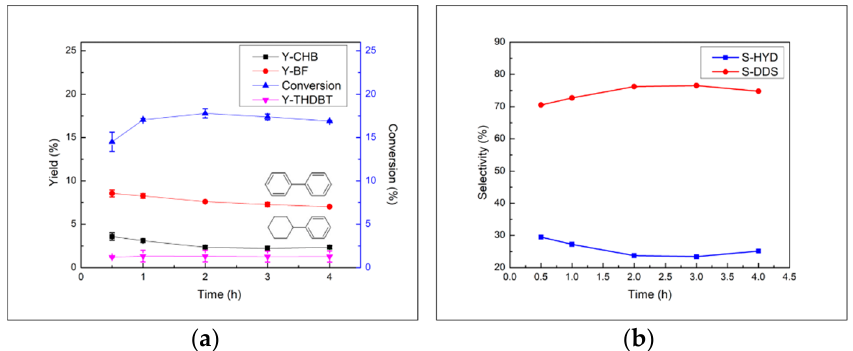
Figure 7. Catalytic performance of NiMo/ γ‐ Al 2 O 3 catalyst. ( a ) Conversion and yield. ( b ) Selectivity.